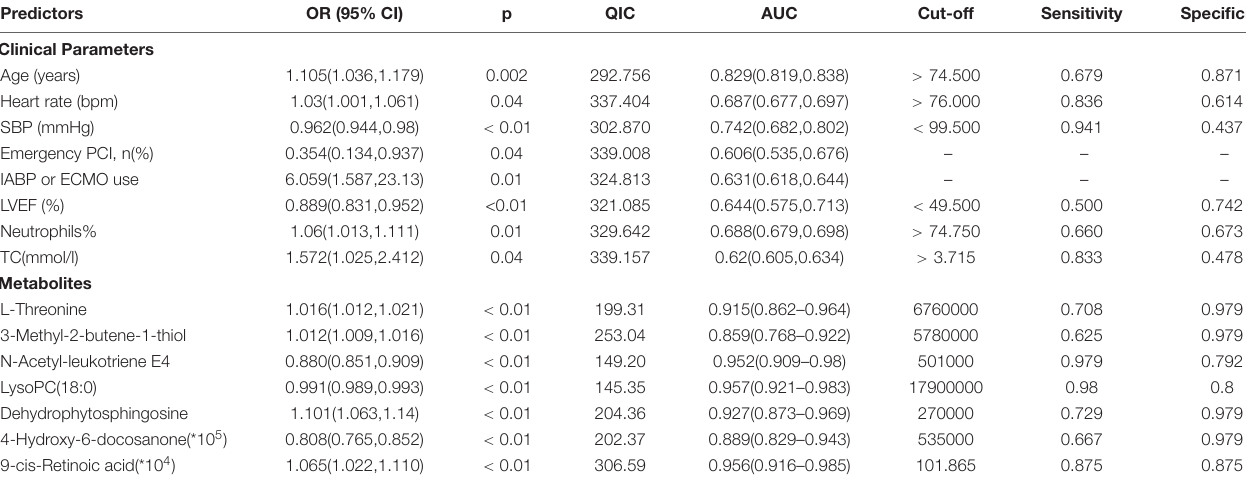
TABLE 5 | Univariate GEE model for patients with ST-segment elevation myocardial infarction (STEMI) with the full dataset for mortality.